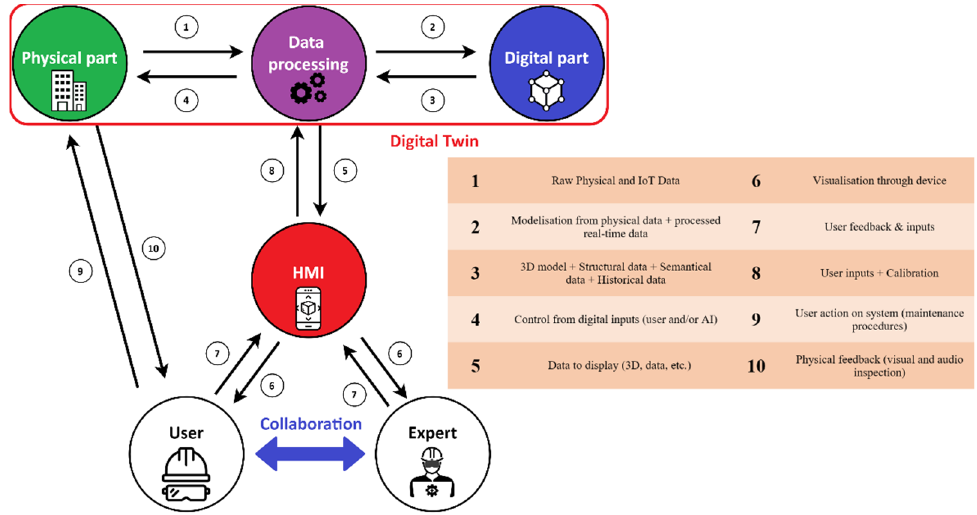
Figure 16. Interactions for an on-site user and a remote